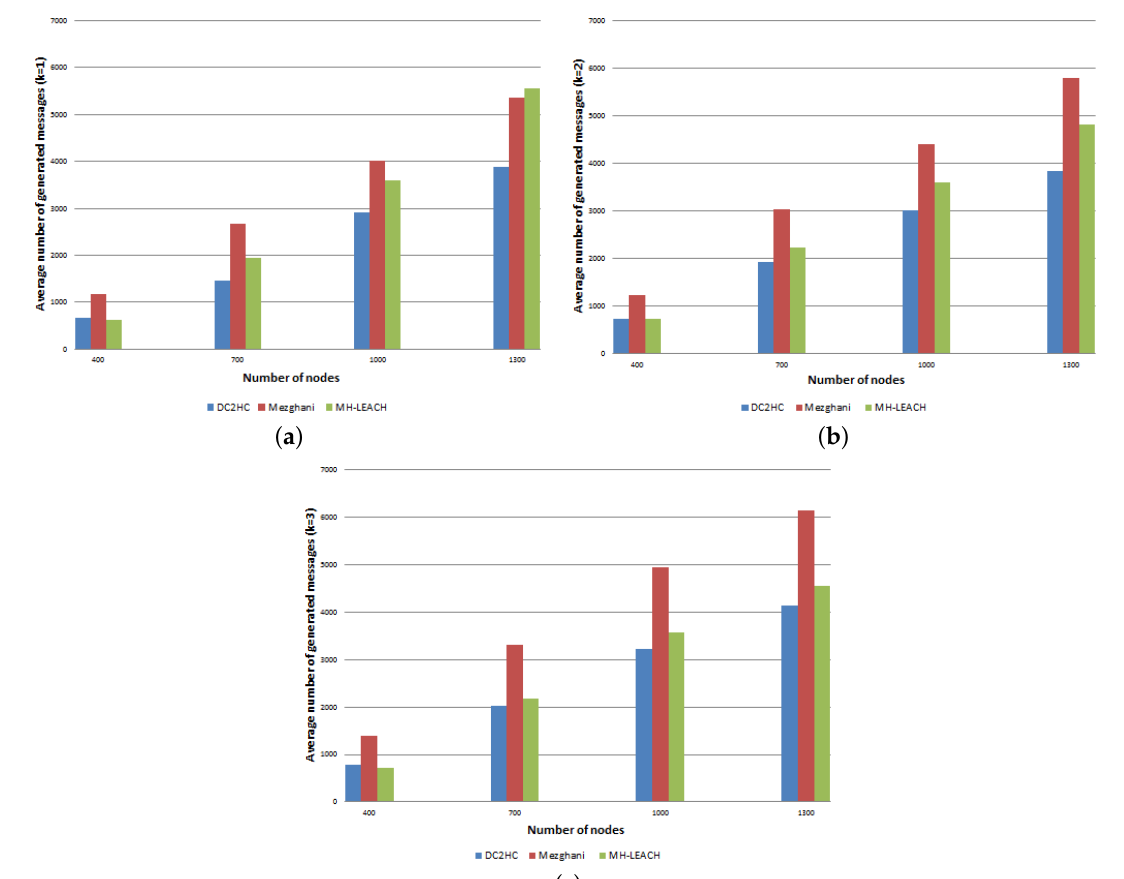
Figure 14. Average number of exchanged messages during the clustering process ( a ) k = 1, ( b ) k = 2, ( c ) k =